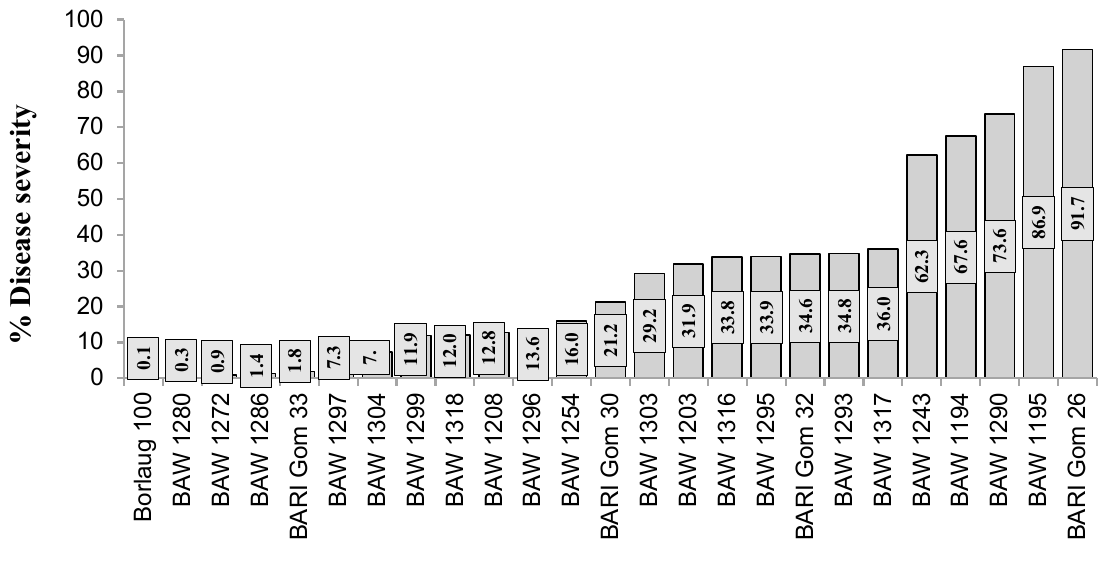
Fig. 6 Elite germplasm screening against wheat blast under the artificially inoculated condition. Adapted from